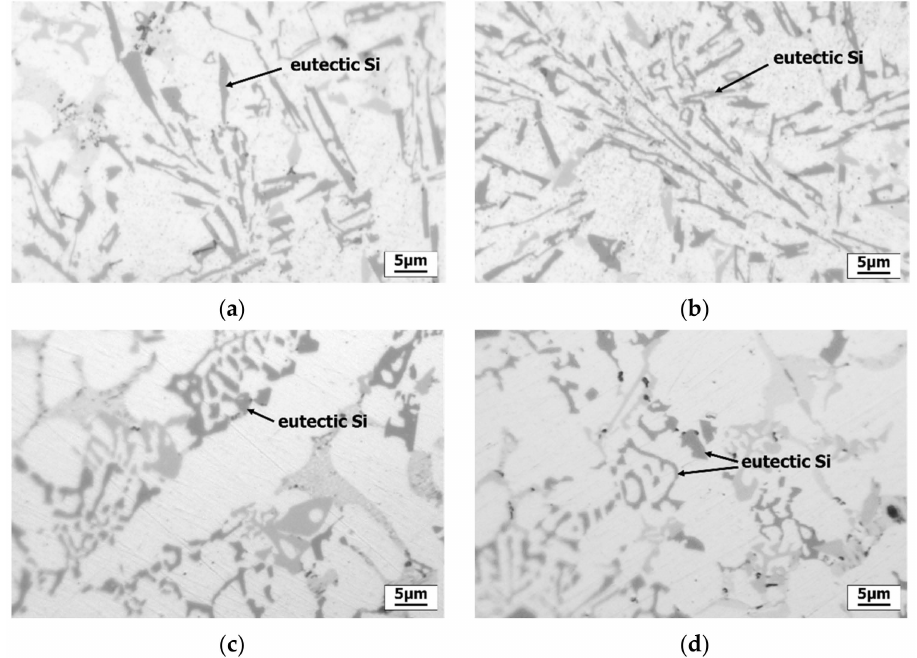
Figure 7. Optical micrographs showing the effect of Bi and P on the eutectic phases of ( a ) B390-0.5Bi